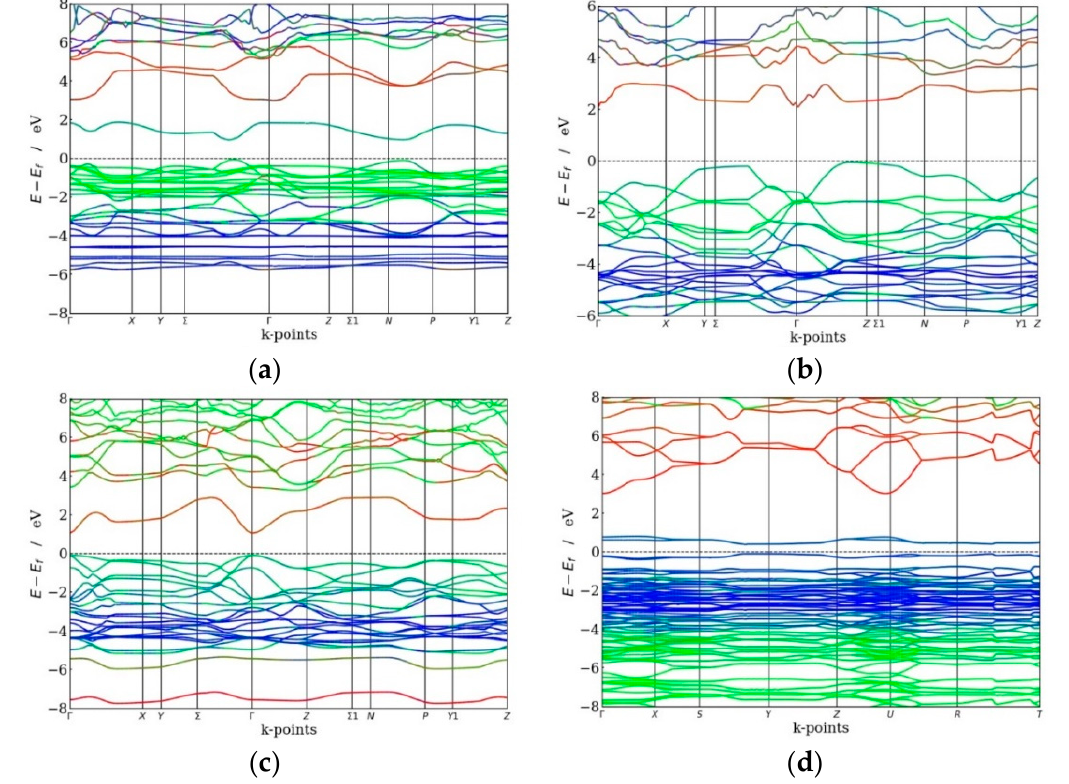
Figure 2. Calculated electronic band structure of ( a ) Au 2 Cs 2 I 6 , ( b ) Ag 2 GeBaS 4 , ( c ) Ag 2 ZnSnS 4 , and ( d ) AgCuPO 4 . Colour code: red line— s states, green line— p states, blue— d states). The Fermi level is set to